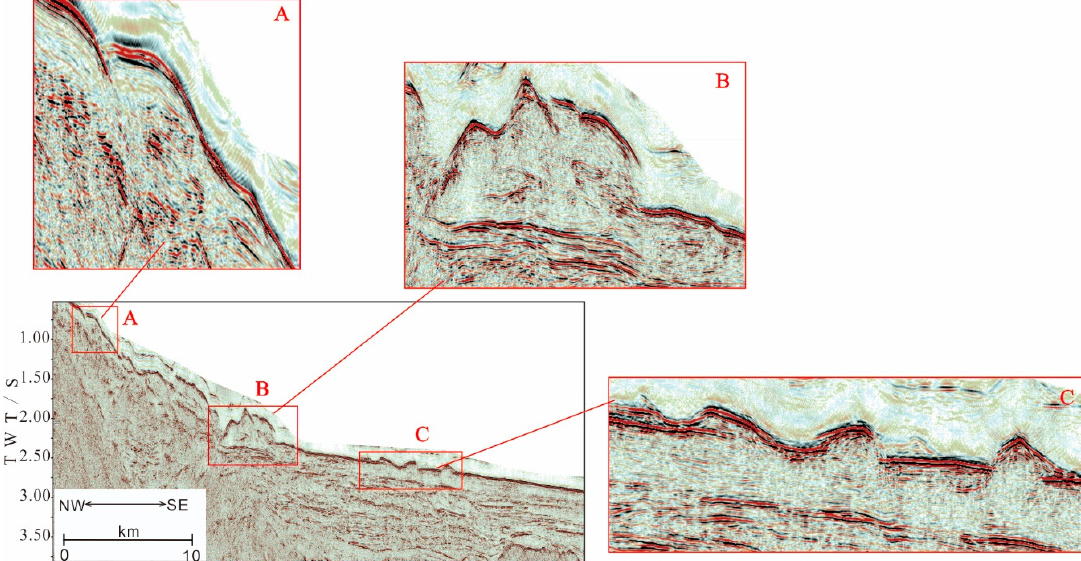
Figure 6. Seismic reflection of Line 5 is a landslide induced by earthquake.